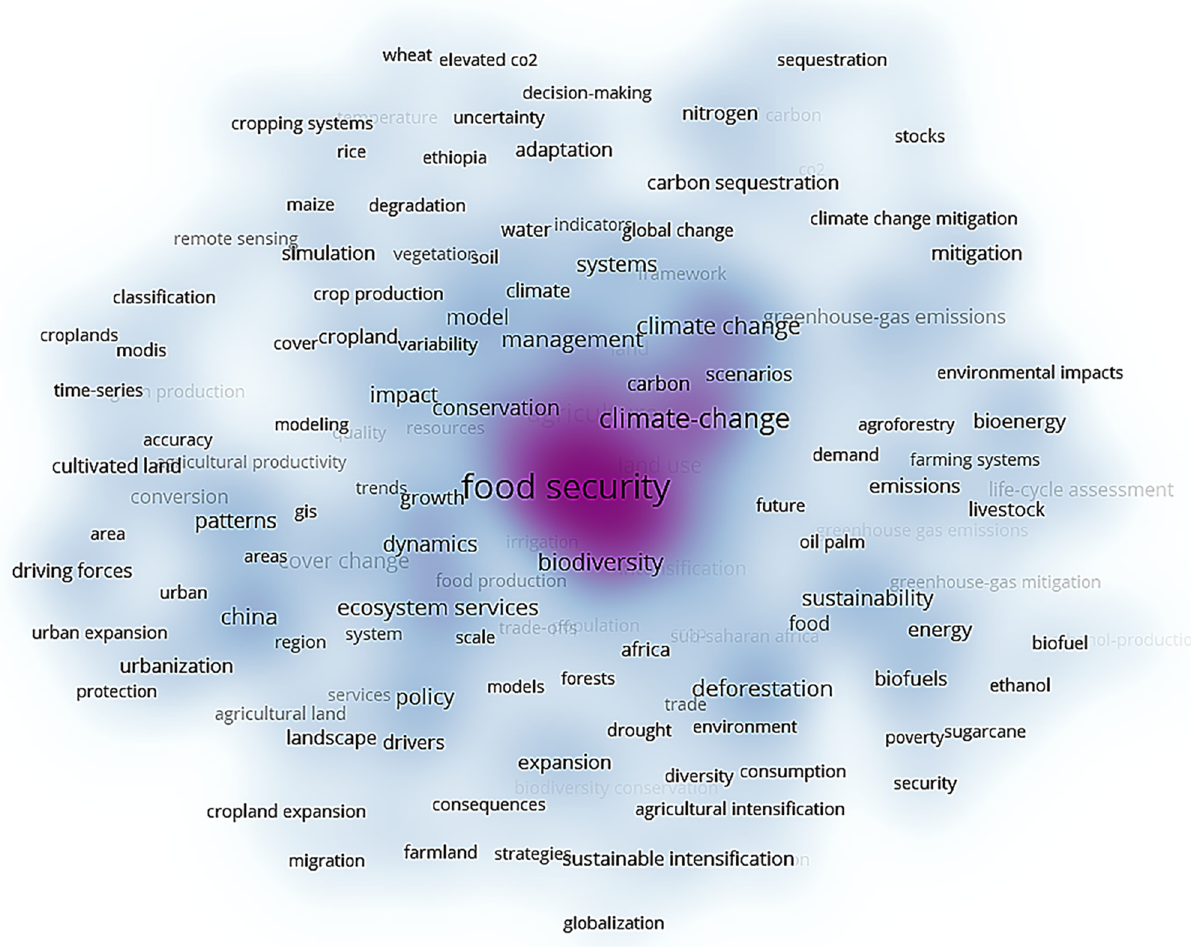
Figure 6. Keyword cooccurrence clustering density map produced by VOSviewer software.